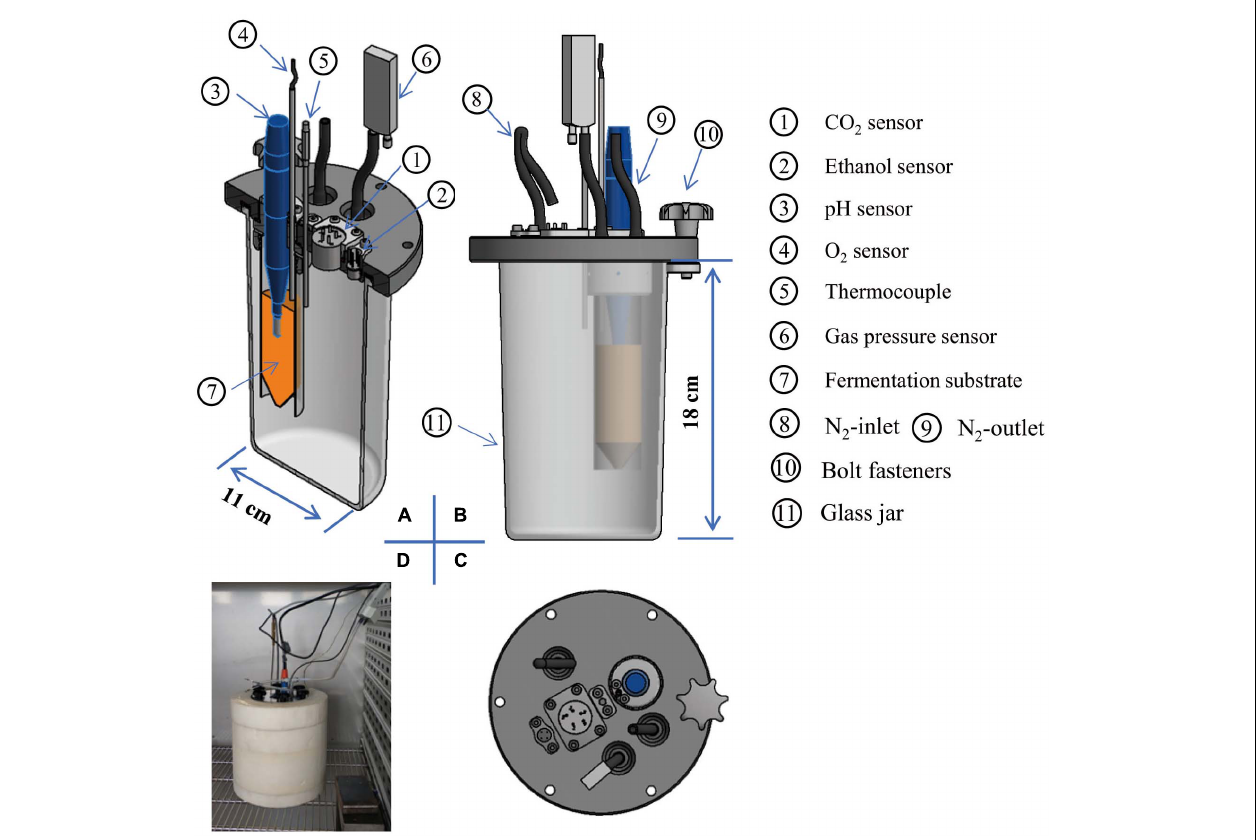
FIGURE 2 | A novel multi-sensor jar, manufactured according to Figure 1 , is shown in cross section (A) , front view (B) , and top view (C) and measured in situ in the incubator (D)